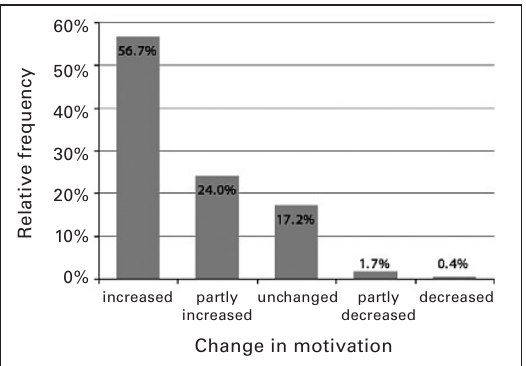
Figure 2 Self-reported change in motivation due to the one-on-one tuto- rials.The figure shows relative fre- quencies of nomina- tion for each re- sponse